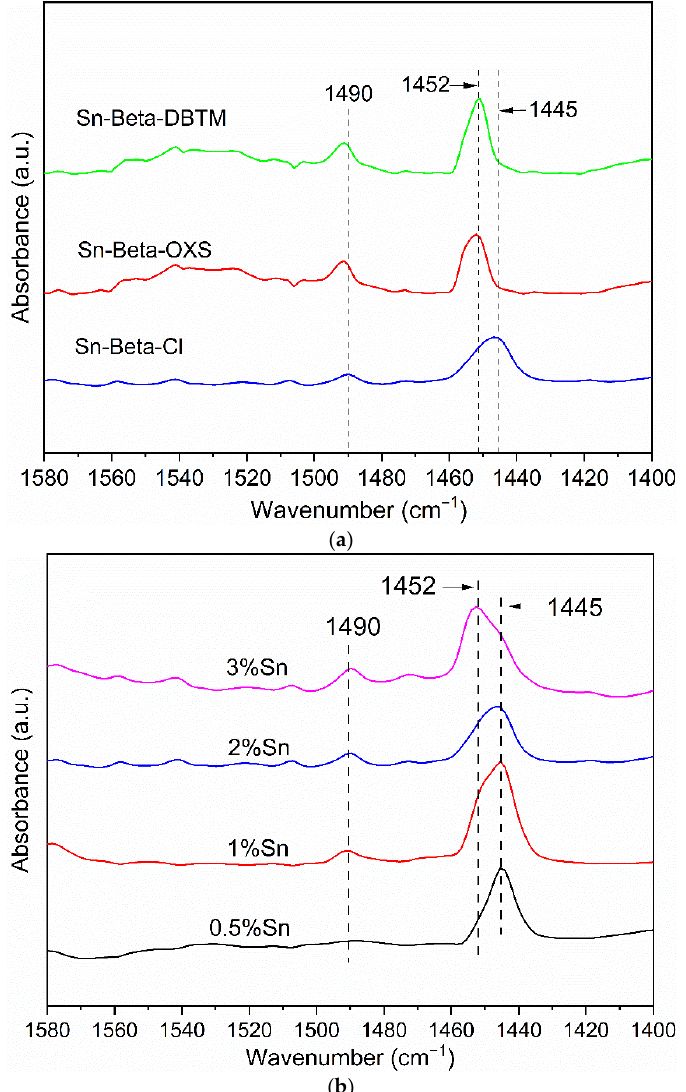
Figure 3. The FTIR spectroscopy of pyridine adsorption of Sn- β prepared from different Sn sources ( a ) and Sn- β -Cl with different Sn content ( b ).